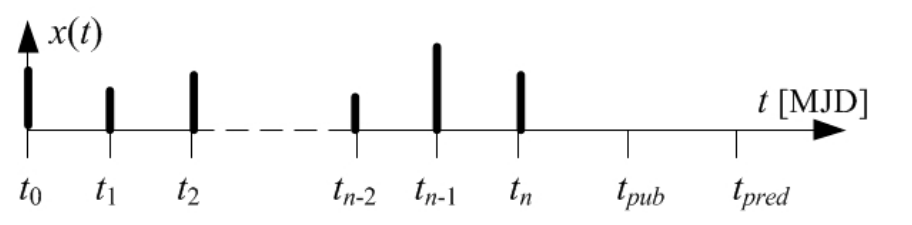
Figure 2. Illustration of time series x ( t ).